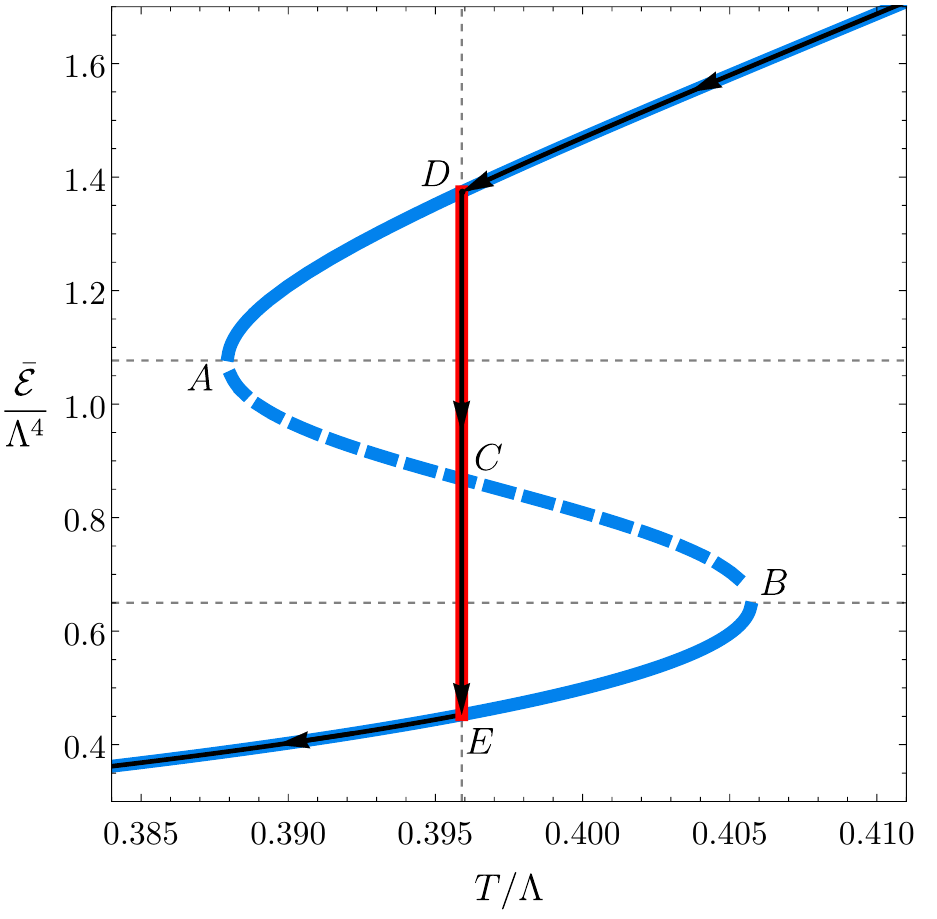
Figure 1 . Phase diagram in the infinite-volume limit. The dashed, vertical line indicates the critical temperature T = T c . The blue curve corresponds to homogeneous states. The red line corresponds to inhomogeneous, phase-separated states. Solid segments indicate locally dynamically stable states; dashed segments indicate unstable ones. The black curves with arrows indicate the sequence of maximum-entropy states as the average energy density E decreases. In the canonical ensemble there is one first-order phase transition at which the system jumps betweens points D and E . In the microcanonical ensemble there are two second-order phase transitions at points D and E between homogeneous and inhomogeneous